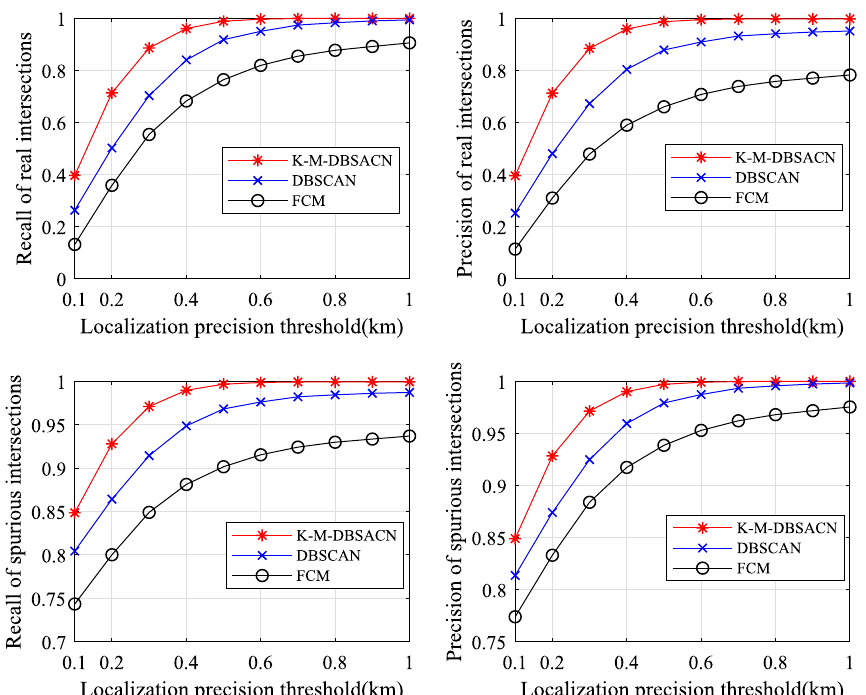
Fig. 6 Comparison of recall and precision versus the localization precision